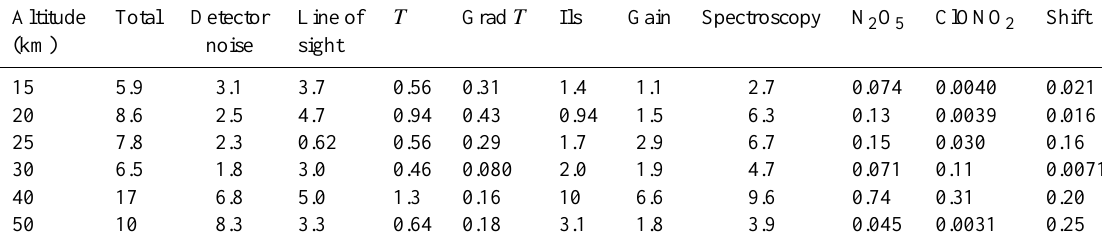
Table 3. As Table 2, but for N 2 O (version V5R_N2O_224). Altitude